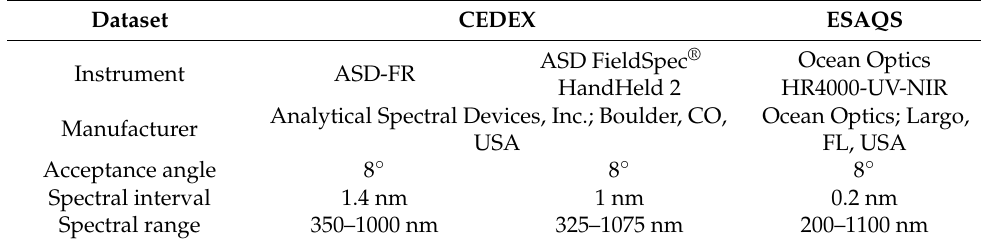
Table 1. Details on field spectroradiometers used to collect water-leaving radiance.